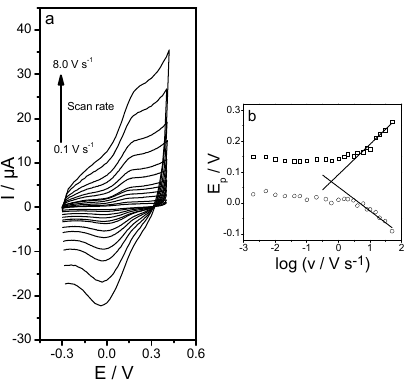
Figure 2. ( a ) Cyclic voltammetric response of 3,4DHS–AuNP/SPCE in 0.1 M phosphate buffer (pH 7) at different scan rates; ( b ) Laviron’s plot showing the dependence of the peak potential on the logarithm of scan rate.